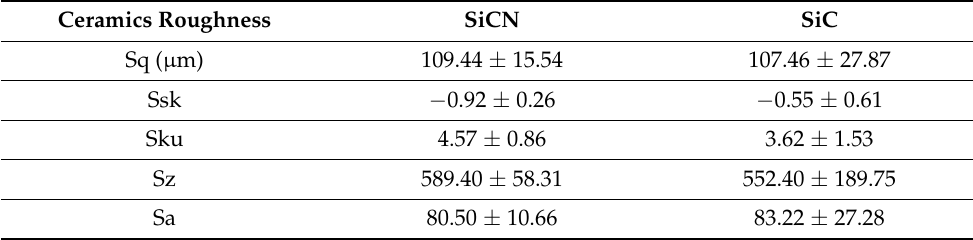
Table 4. Surface roughness of ceramics. Ceramics